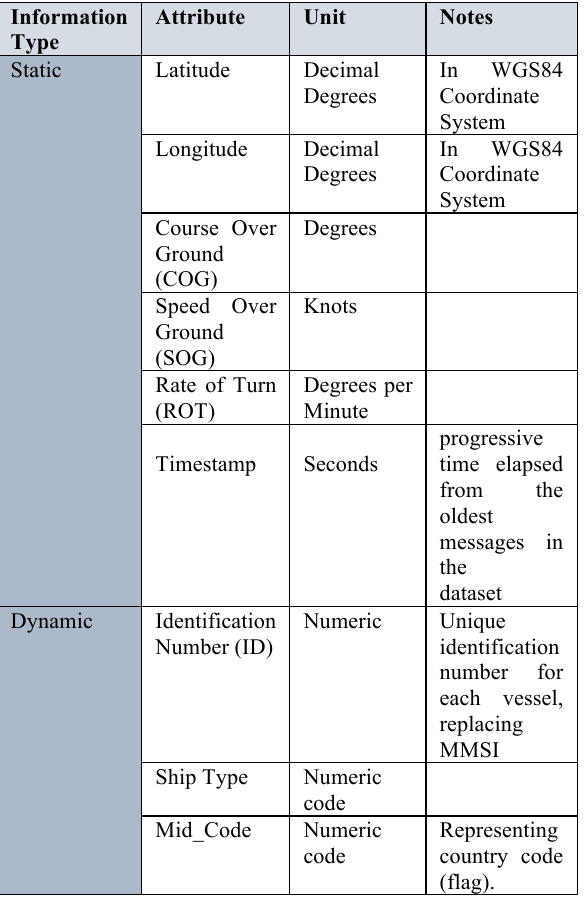
Figure 2. Known Migrant Vessels Table 2. Vessel Data